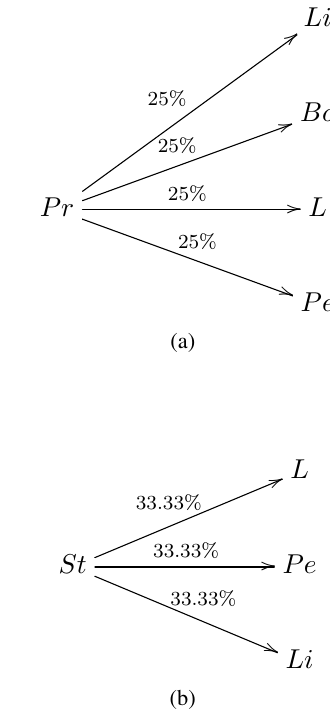
Fig. 3: Probabilities (in percentage) of metastasis in organs from Prostate (a) and Stomach (b) cancer